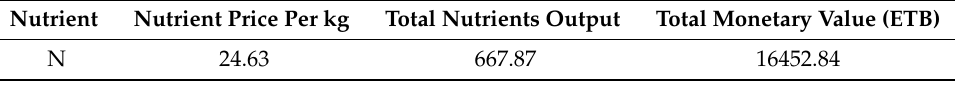
Table 4. The value (ETB) of nitrogen in manure produced on farms. Nutrient